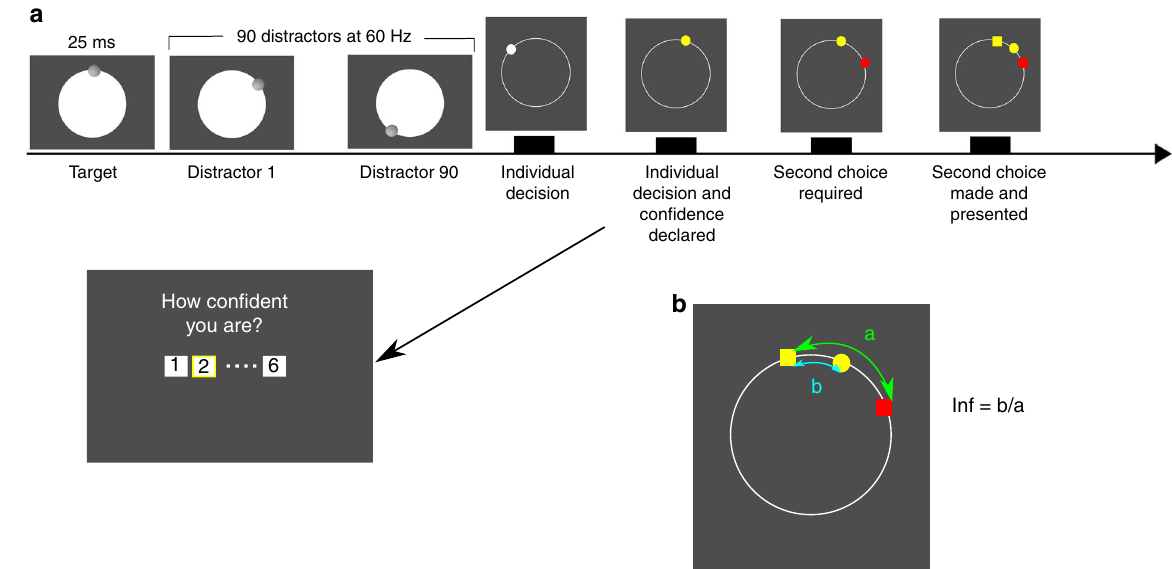
Fig. 1 Experimental task. a Participants fi rst observed a series of dots on the screen. Participants were required to indicate where they saw the very fi rst dot (yellow dot) and then declare their numerical con fi dence. After making their individual estimates, they were presented with the estimate of a partner (red dot) concerning the same stimulus. After observing the partner ’ s choice, in some trials the participants and in other trials the partner was given a second chance to revise their initial estimate. Afterwards, they were brie fl y presented with their initial choices and the second choice. In experiment 1, they did the task with three different alleged human partners, which only varied in the second choice strategy in different blocks: in the baseline blocks, the participant made all second choices. In the susceptible blocks, the partner was very in fl uenced by the participant ’ s fi rst choice, however in the insusceptible blocks, the partner was much less in fl uenced by the participant ’ s fi rst choice compared to susceptible blocks. b In fl uence was computed as the angular displacement toward the peer ’ s choice divided by their initial distance from each other ’ s